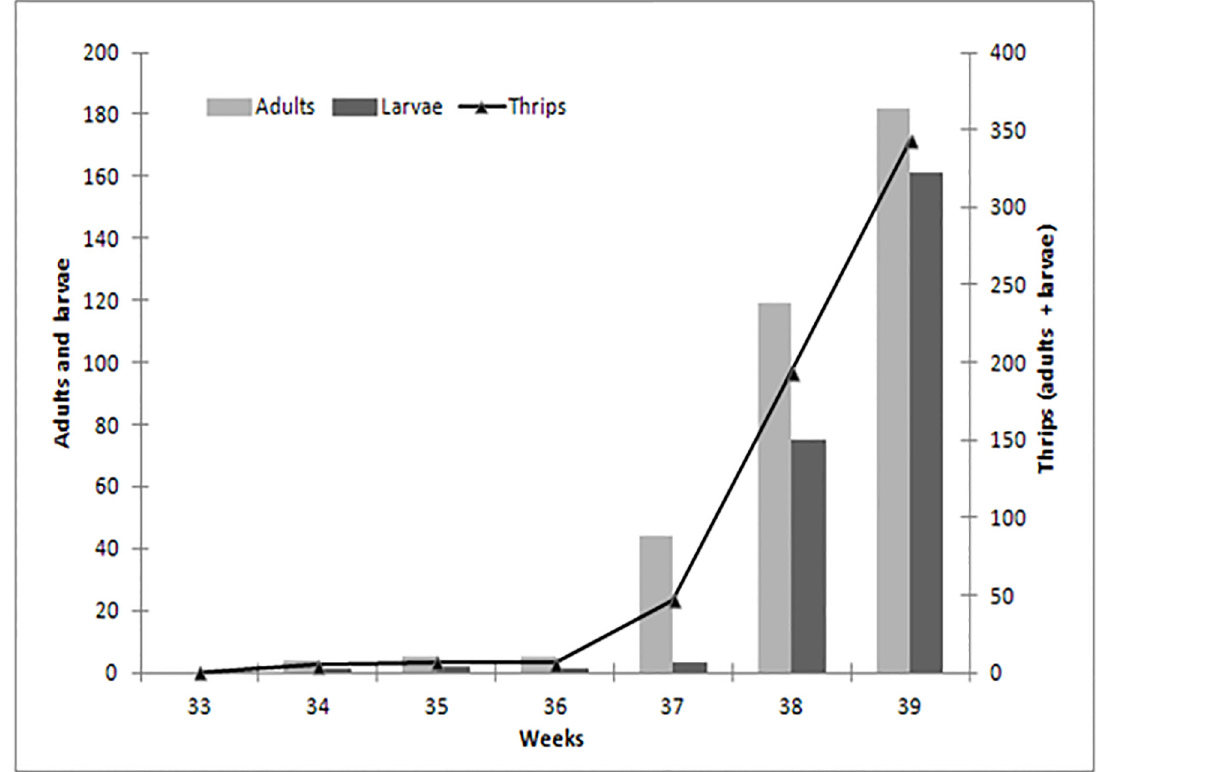
Fig 2. Time evolution of larvae and adults population of thrips in the experimental